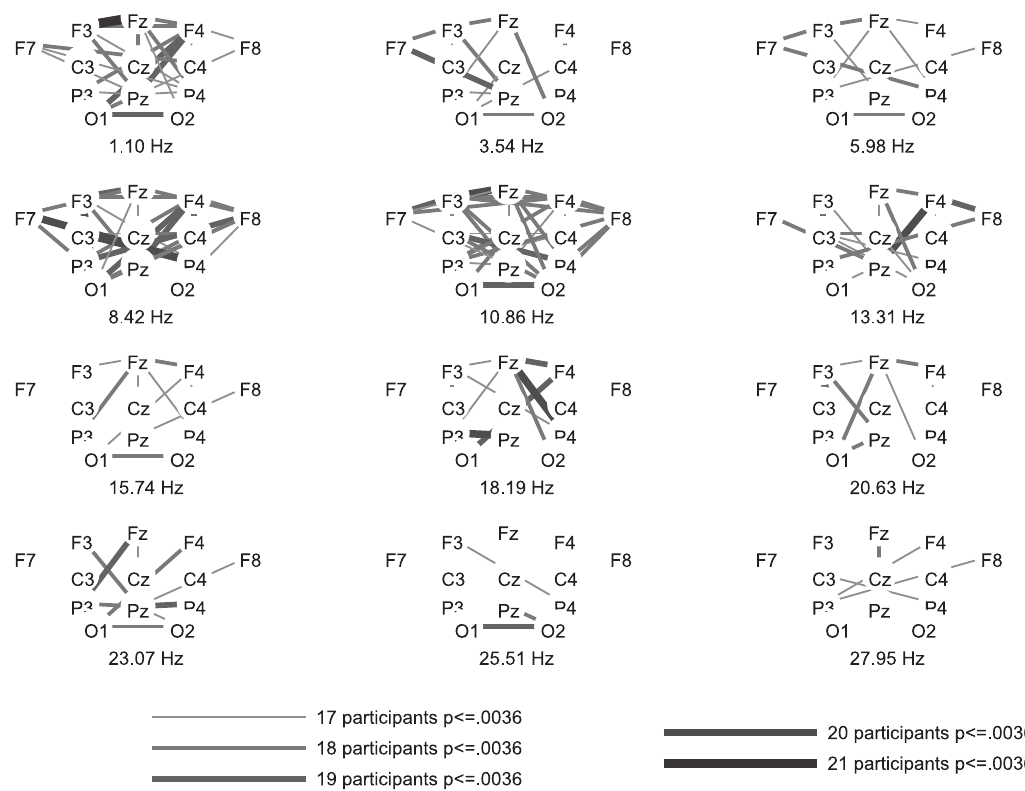
Figure 5. Numbers of healthy participants with significant (FDR-corrected) coherences.